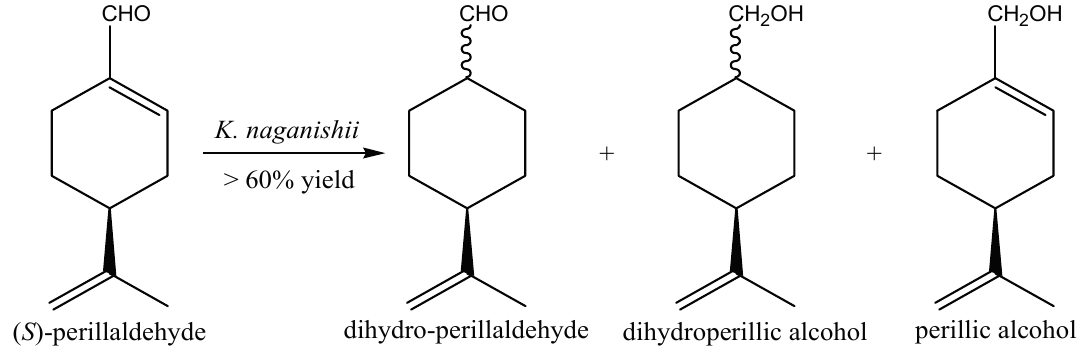
Figure 6. Bioconversion of ( S )-perillaldehyde by NCY K. naganishii